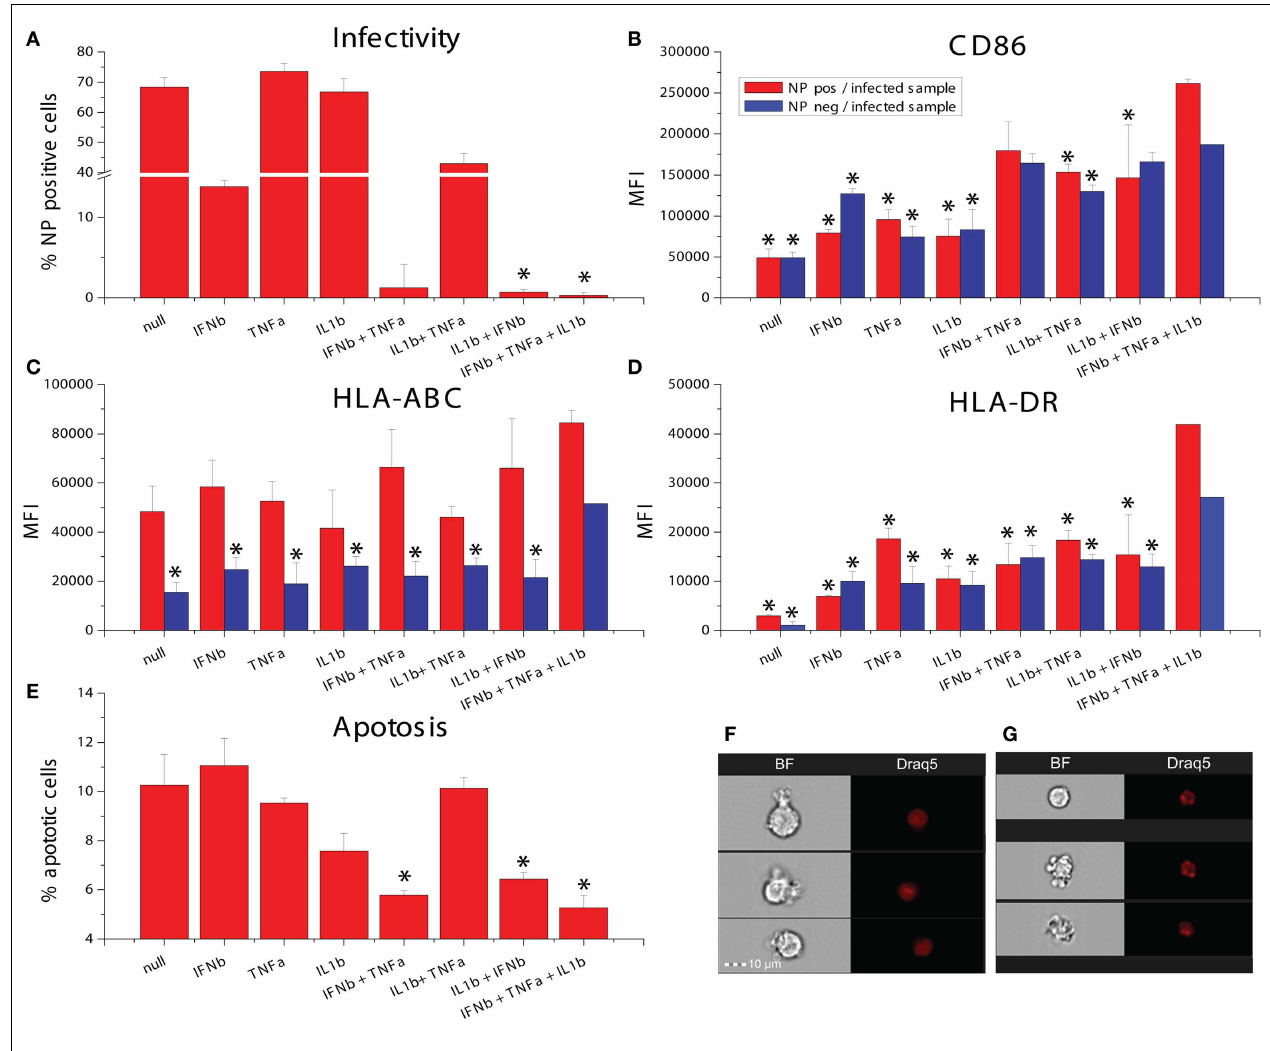
maturation marker HLA-DR (* p ≤ 0.05 compared to cells exposed to the triple combination ofTNF α , IFN β , and IL1b). (E) Apoptosis assayed by assessing nuclear fragmentation and cell granularity by imaging flow cytometry (* p ≤ 0.05 compared to untreated cells). (F) Sample images of non-apoptotic cells. (G) Sample images of apoptotic